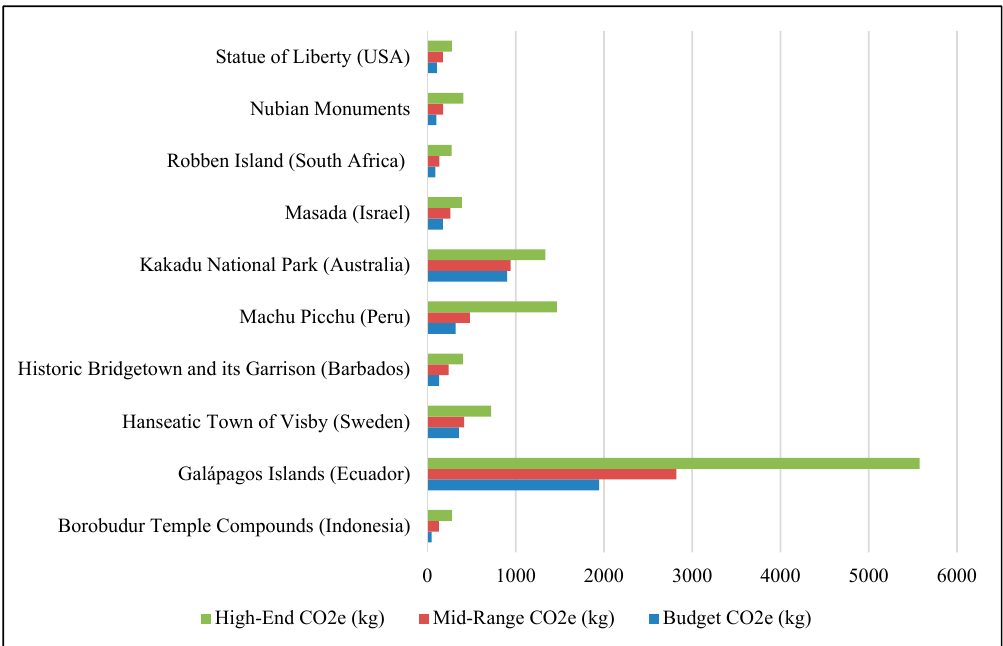
Figure 1 . The average carbon dioxide equivalent (CO2e) emissions for three types of trips to selected WHS: High-End, Mid-Range, and Budget. For reference, 100 kilograms of CO2e emissions is equivalent to the carbon sequestered by growing 1.7 tree seedlings for 10 years [54]. For some sites in the CCRS we calculated multiple kinds of trips for each type (for example, multiple mid-range options using di ff erent forms of transportation), but in the above graph we have averaged these in the relevant expenditure category (High-End, Mid-Range, or Budget) to simplify the graphical